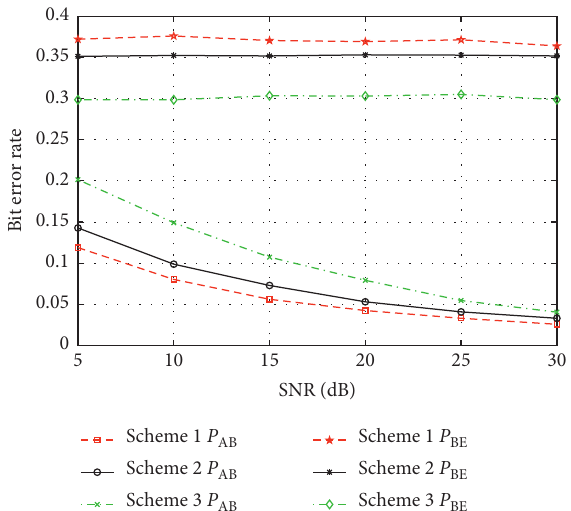
Figure 5: Variation of bit error rates between the secret key random parameters of Bob and Alice (EVE) with channel SNR.